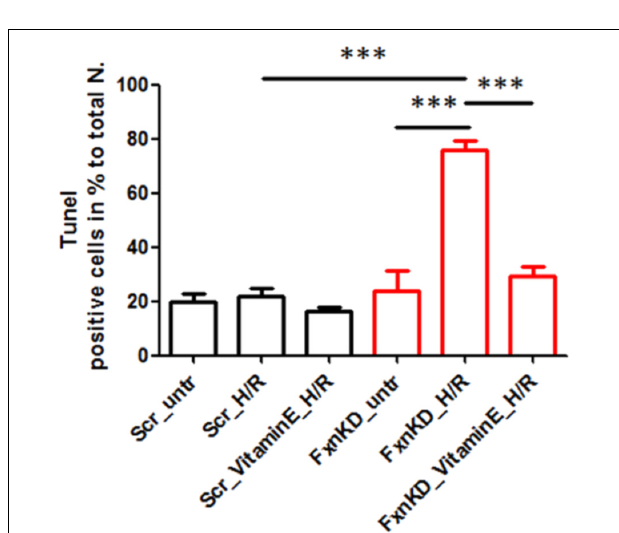
FIGURE 9 | Vitamin E prevents cell death after hypoxia reperfusion. FxnKD cardiomyocytes exposed to H/R revealed an enounced vulnerability as the cell death increased significantly. However, cells pre-treated with Vitamin E seemed to be protected. The numbers of TUNEL-positive cells were calculated and the apoptotic cell death was expressed as percentage ( ∗∗∗ p <